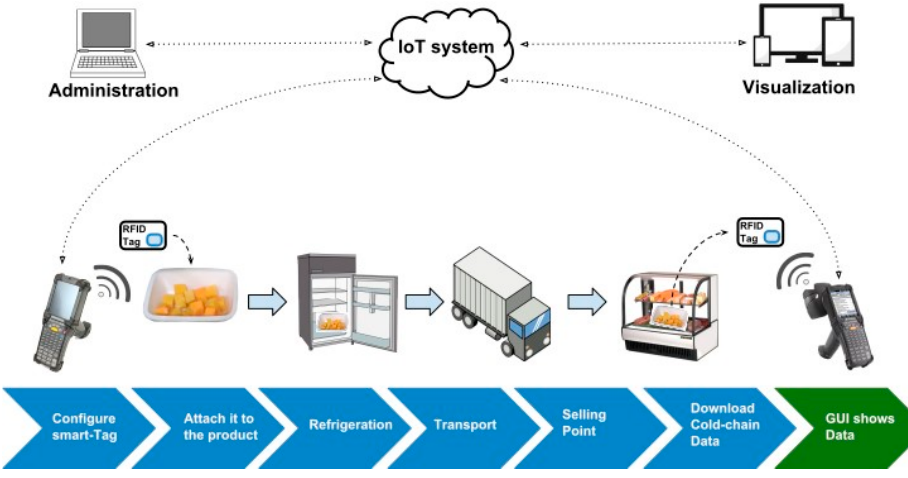
Figure 5. Experiment diagram.